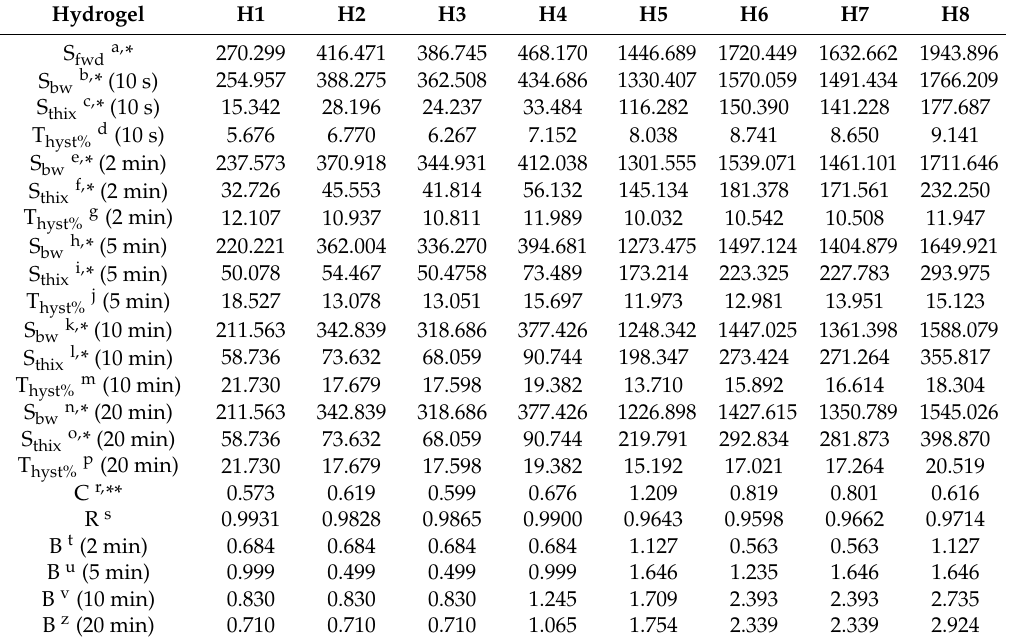
Table 5. Thixotropic parameters for hydrogels H1–H8 tested at 23 ˝ C.